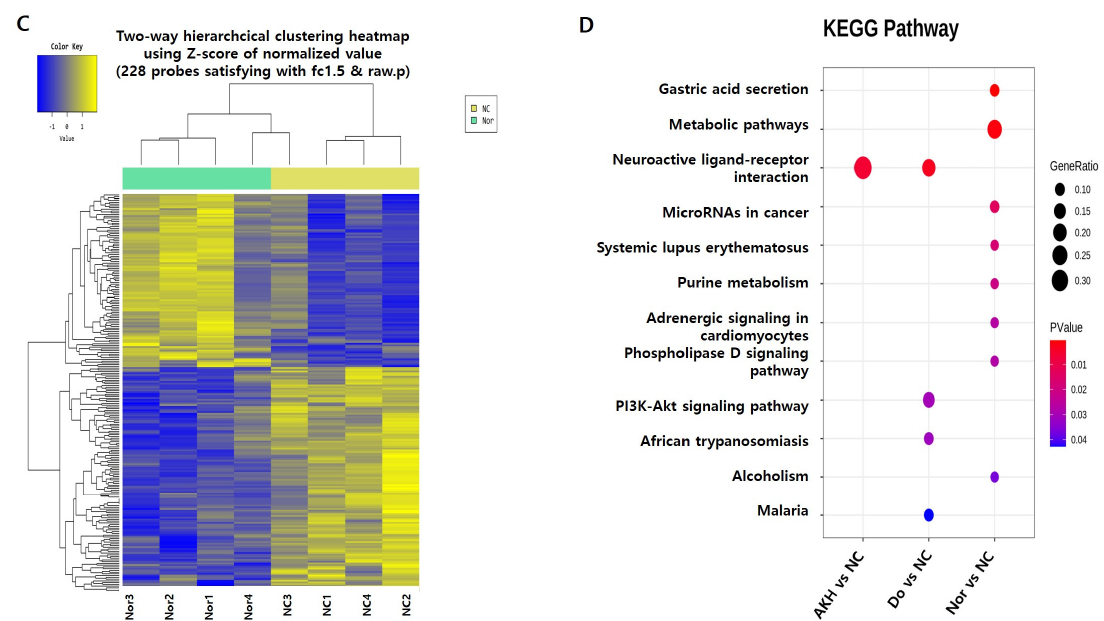
Figure 8. Effect of AK extracts on hippocampal gene expression in chronically scopolamine-treated rats using microarray assay. One-way hierarchical clustering heatmap of ( A ) AKH vs. NC, ( B ) Donepezil (Do) vs. NC, and ( C ) Nor vs. NC. ( D ) Dot plot image of differential pathways and data between AKH vs. NC, Donepezil vs. NC, and Nor vs. NC using KEGG pathway analysis. The rats were randomly divided into five groups: Nor: normal, commercial diet + saline; NC: negative control, commercial diet + scopolamine in saline; AKH: commercial diet of AK extract 0.42% + scopolamine in saline; Donepezil: commercial diet + Donepezil 1 mg/kg in saline + scopolamine in saline ( n = 4). All rats, except those in the normal group, were intraperitoneally administered scopolamine (1 mg/kg/day) for 21 days. Food and water were freely accessible. Table 1. Data of AKH vs. NC and Donepezil vs. NC from KEGG pathway analysis. MapName Neuroactive ligand -receptor